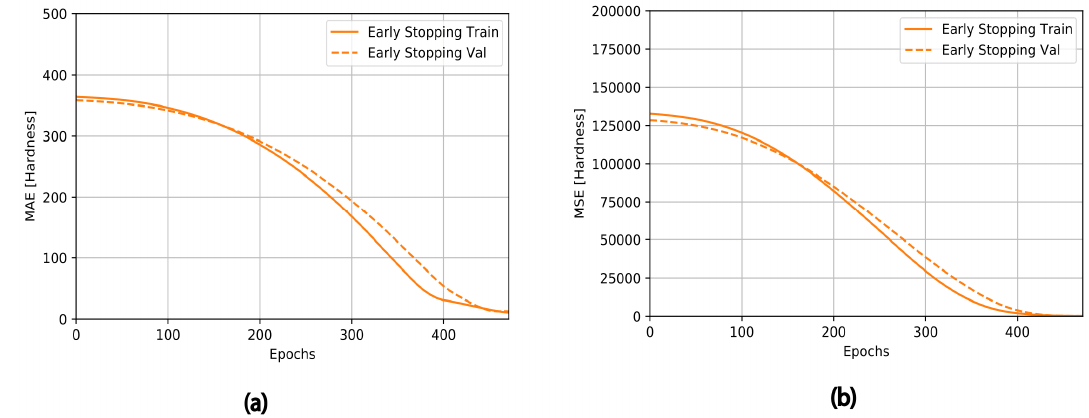
Figure 11. Early stopping plot of ( a ) MAE and ( b ) MSE against epochs. Table 4. Calculated values for R 2 and MAE for training and testing data. Training Model